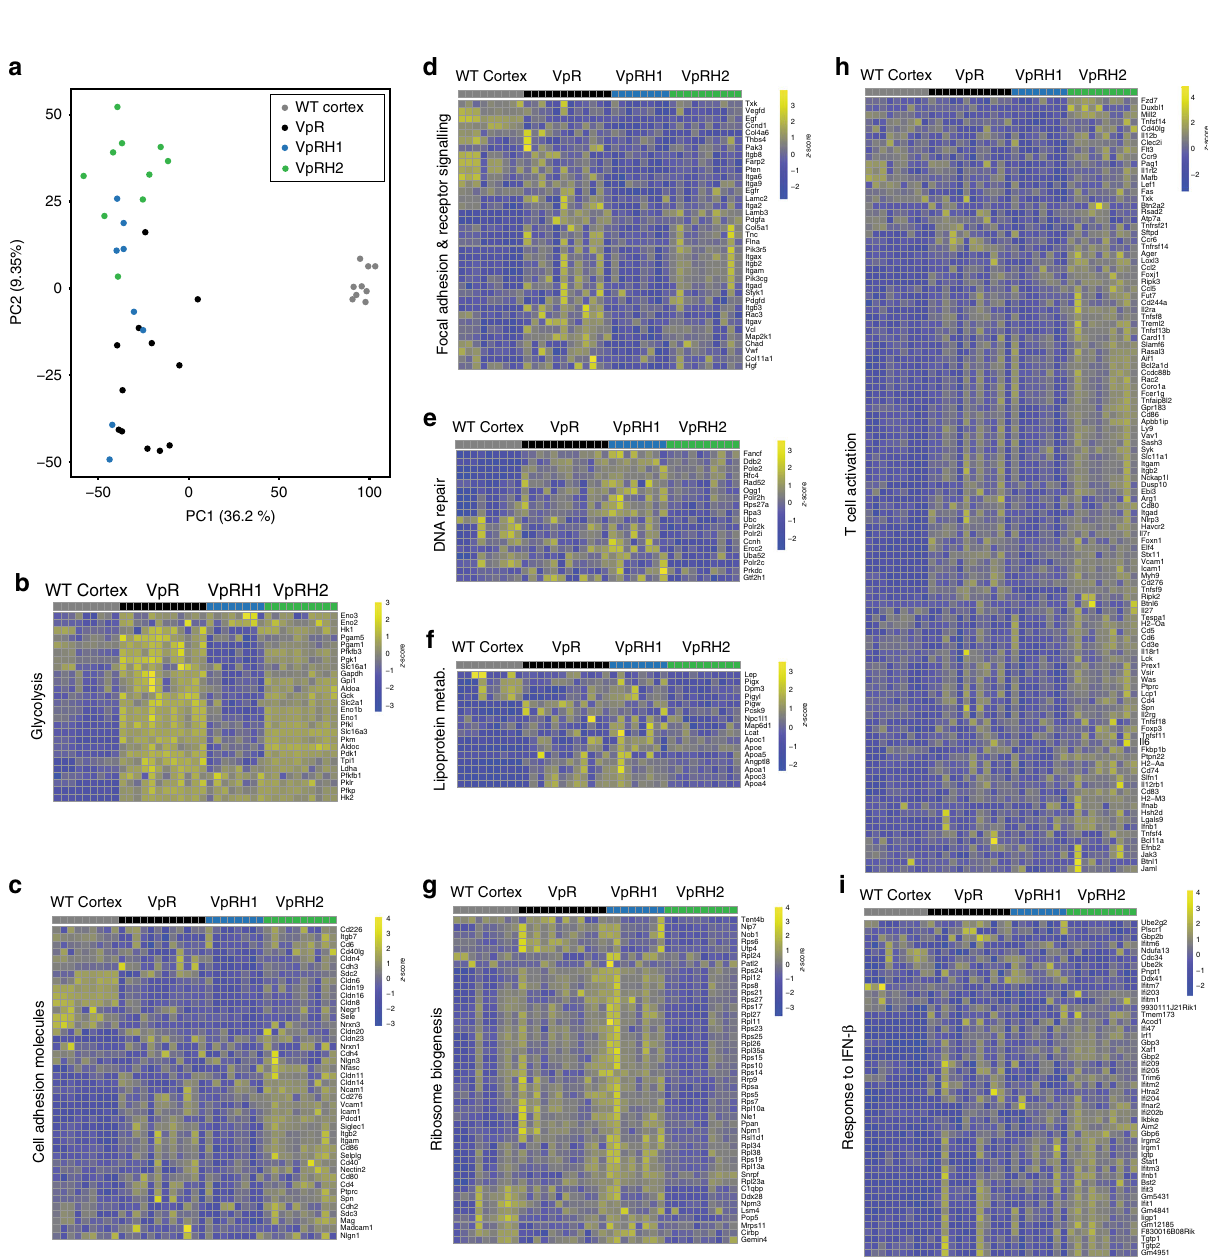
Fig. 3 HIF-1 α and HIF-2 α deletion affect different transcriptional programmes and in fl ammatory responses. a Principal component analysis of RNA sequencing of WT Cortex and VpR, VpRH1, and VpRH2 tumours. Gene expression heatmaps for selected differentially regulated genes from the indicated GSEA terms glycolysis ( b ), cell adhesion molecules ( c ), focal adhesion and receptor signalling ( d ), DNA repair ( e ), lipoprotein metabolism ( f ), ribosome biogenesis ( g ), T-cell activation ( h ), and response to IFN- β ( i ). Rows represent row-normalised z -scores of mRNA abundance, each column represents an individual sample from WT cortex or VpR, VpRH1, and VpRH2 tumours. Source data is provided in Supplementary Data 1 and